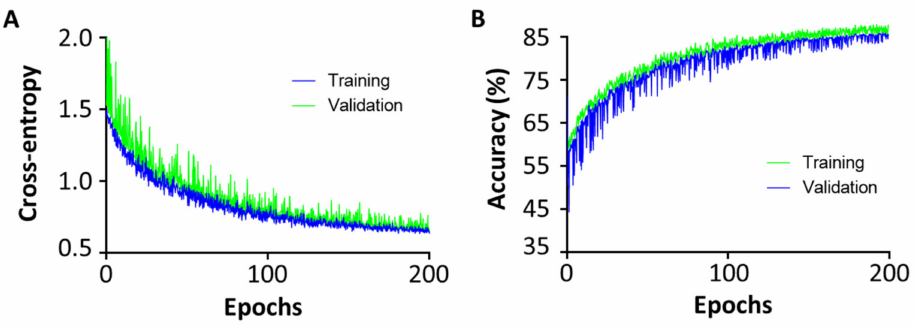
Figure 3. Training curve of multi-DL. ( A ) Cross-entropy vs. training epochs. ( B ) Accuracy vs. training